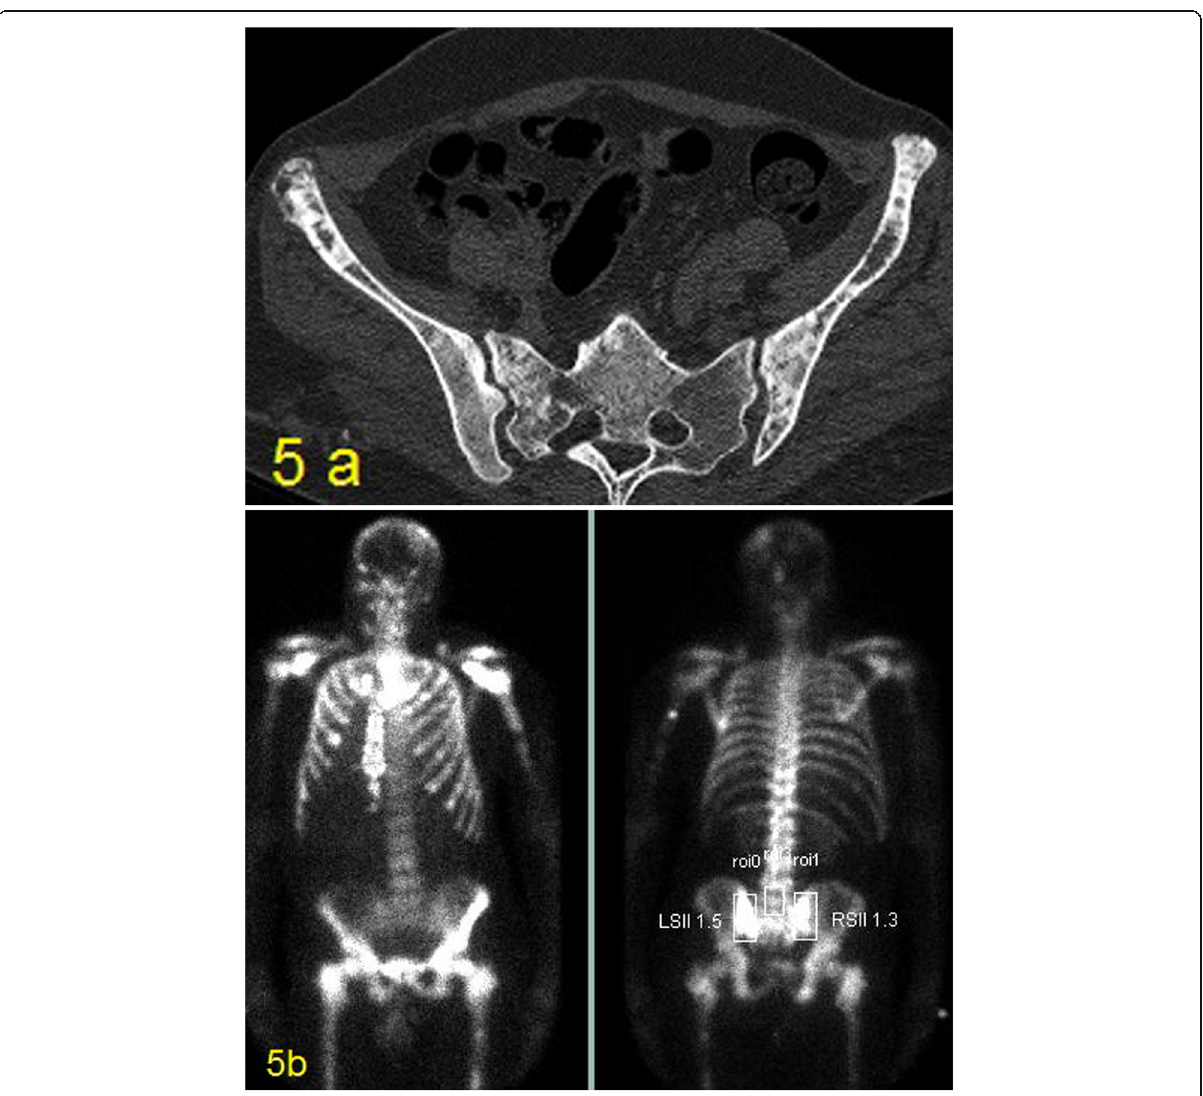
Fig. 5 Forty-five years old male with metastatic cancer prostate. a Axial MSCT (bone window) shows multiple mainly sclerotic bony deposits